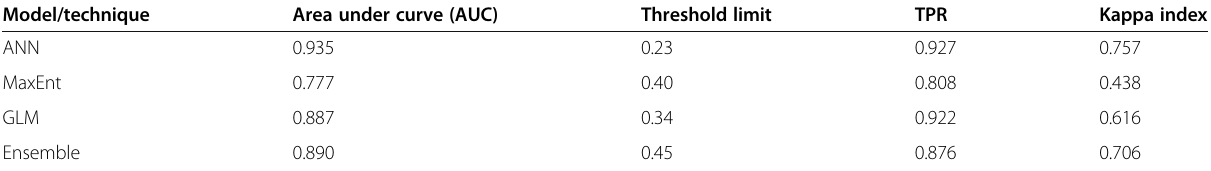
Table 3 Threshold, TPR (true positives rate), and highest kappa value